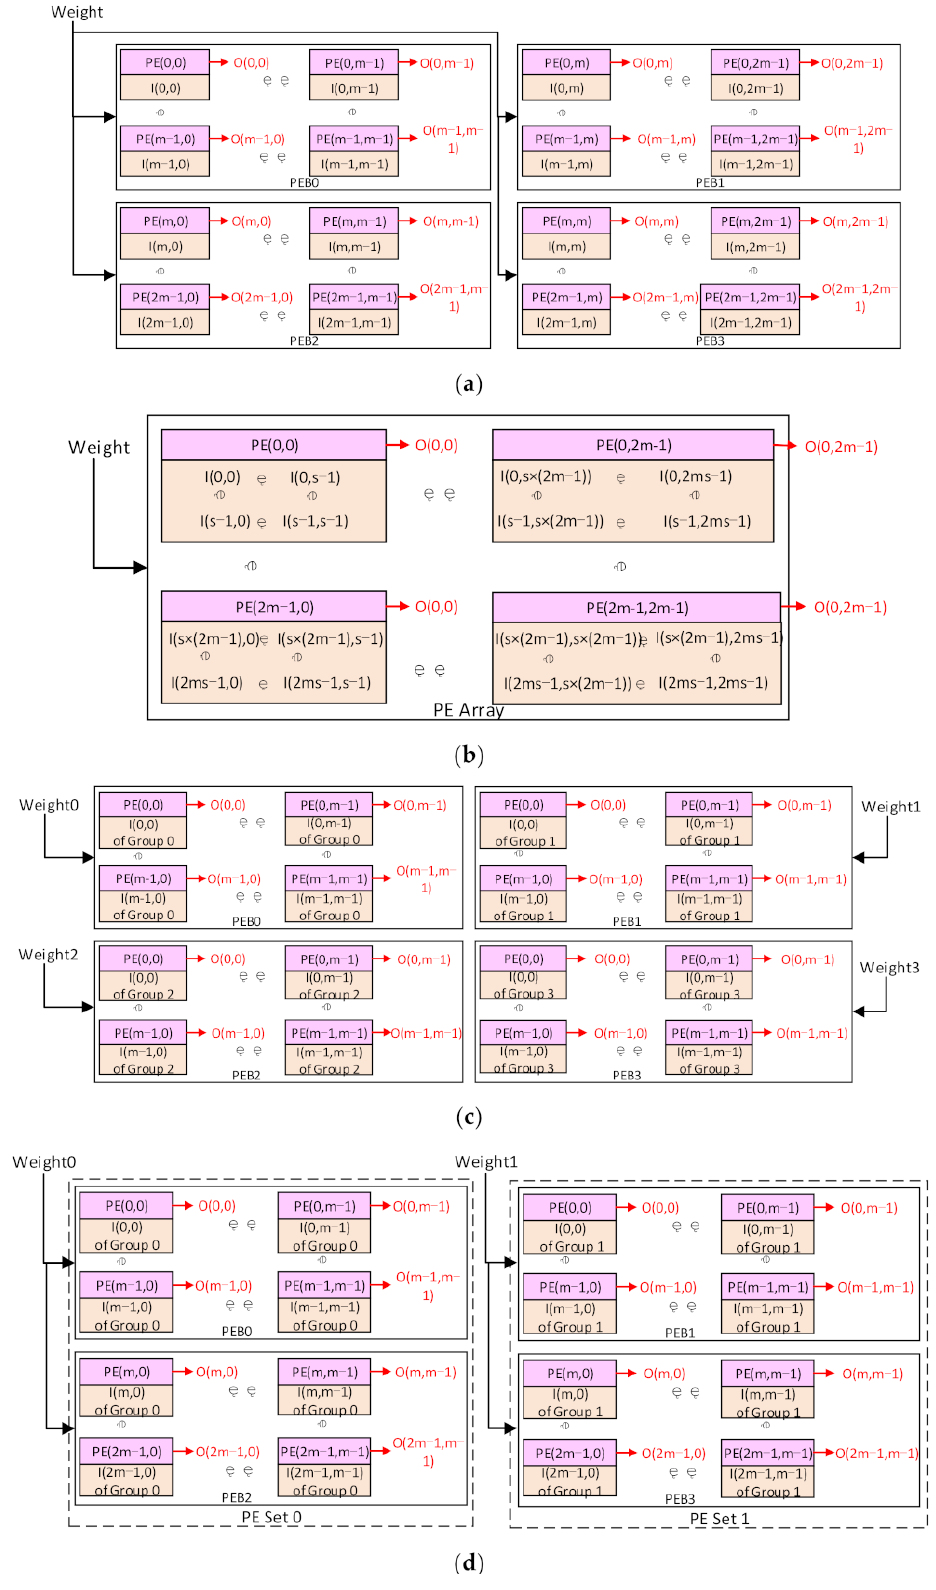
Figure 6. The mapping scheme: ( a ) The 2m × 2m mode with the kernel stride of 1. ( b ) The 2m × 2m mode with the kernel stride larger than 1. ( c ) The m × m mode with the stride of 1. ( d ) The 2m × m mode with the stride of